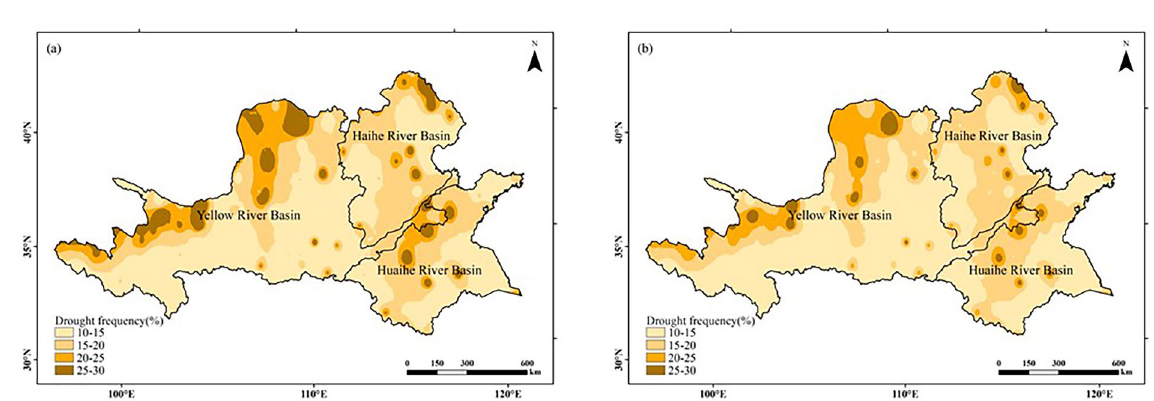
Figure 10. Drought frequency of peanut growing season in Huang-Huai-Hai region in two climatic years: ( a ) 1960–1989; ( b ) 1990–2019. The figure was made in the ArcGIS 10.2 platform (https:// www. esri. com/ en- us/